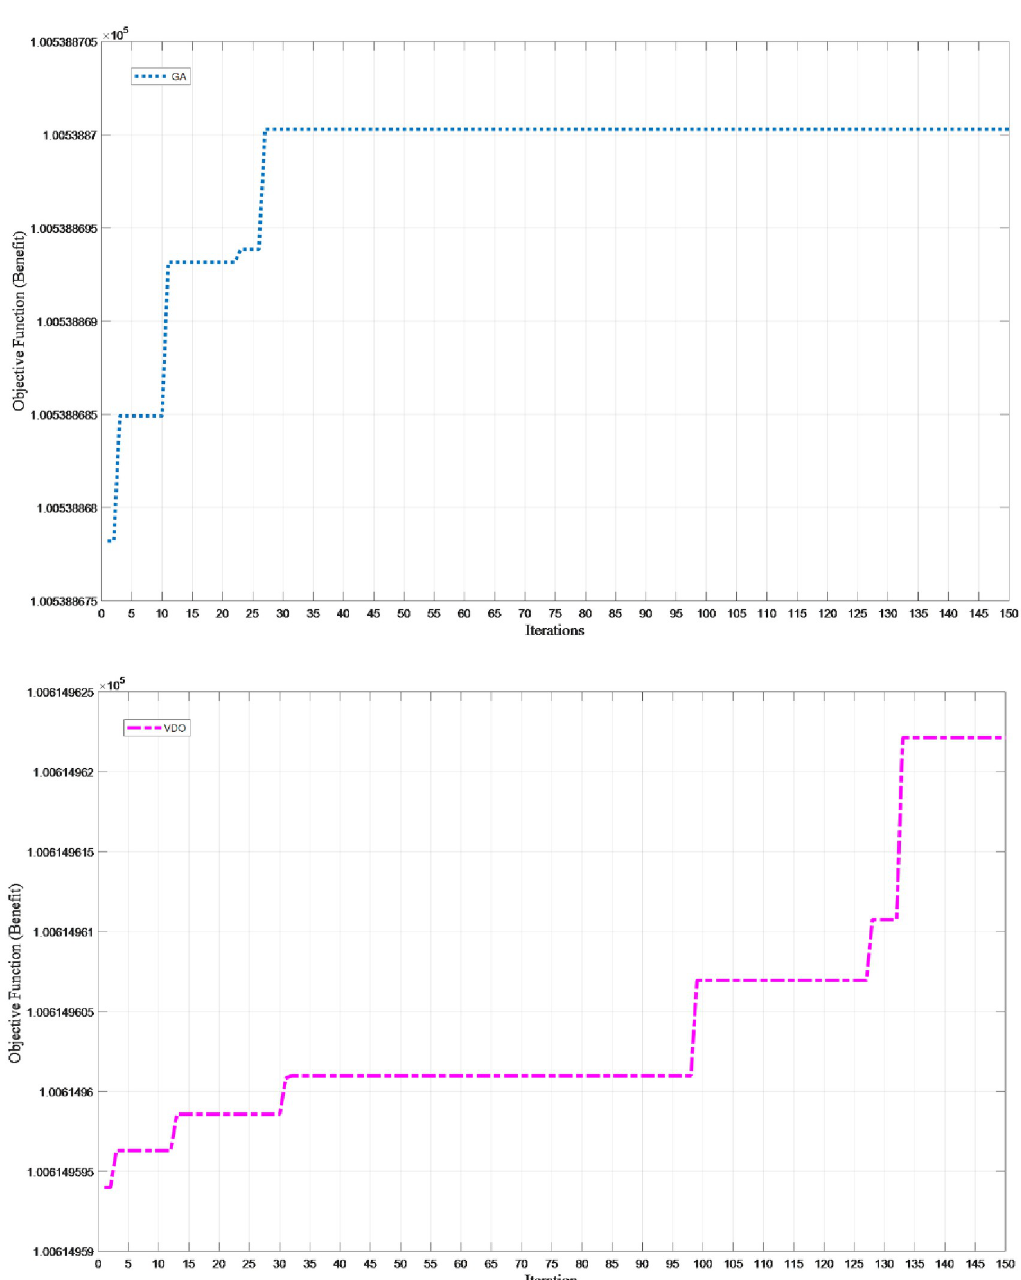
Fig 9. The convergence of the metaheuristic algorithms in 150 consecutive